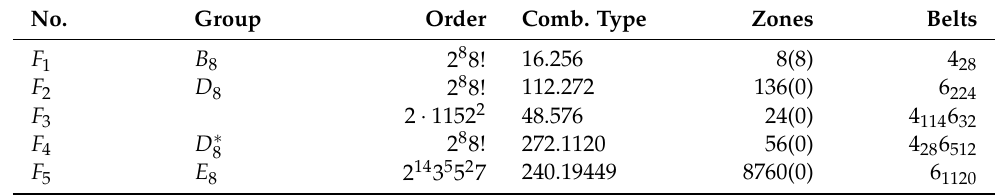
Table 1. The parallelohedra of the maximal finite irreducible subgroups of GL 8 ( ZZ ) . No. Group Order Comb. Type